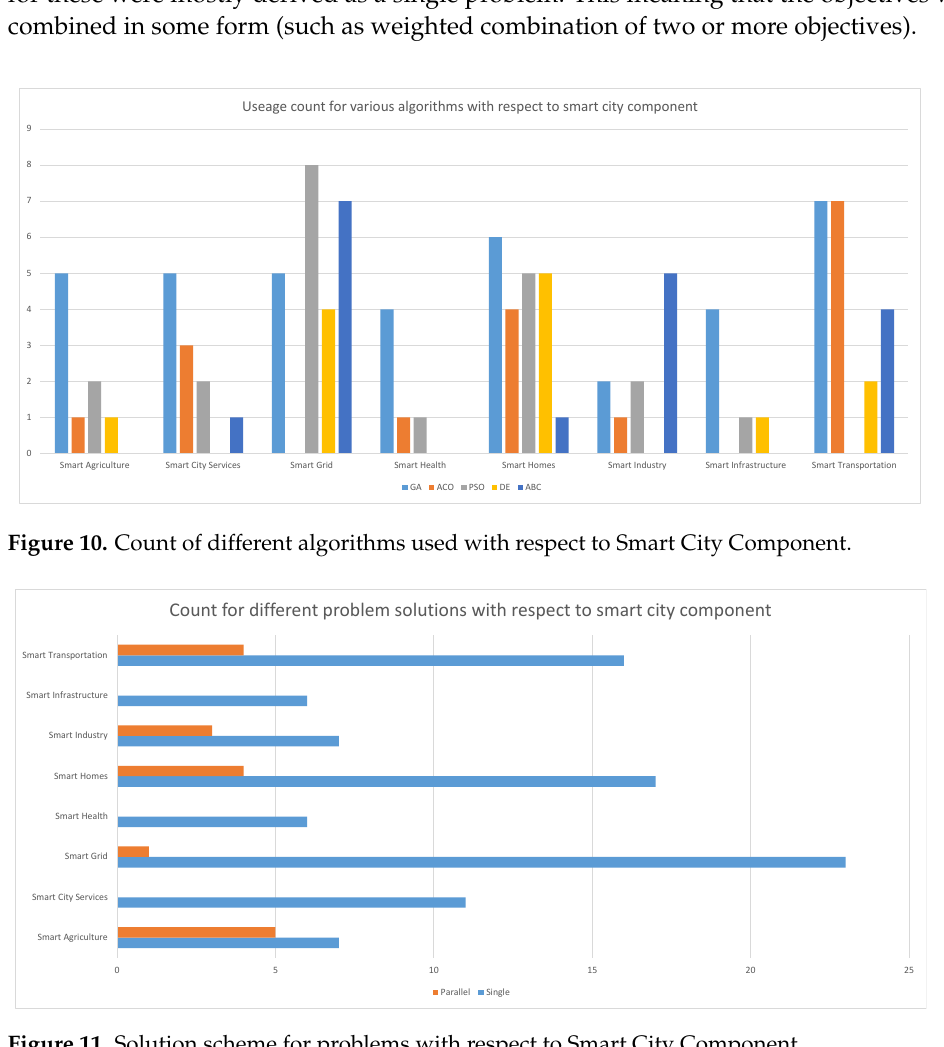
Figure 11. Solution scheme for problems with respect to Smart City